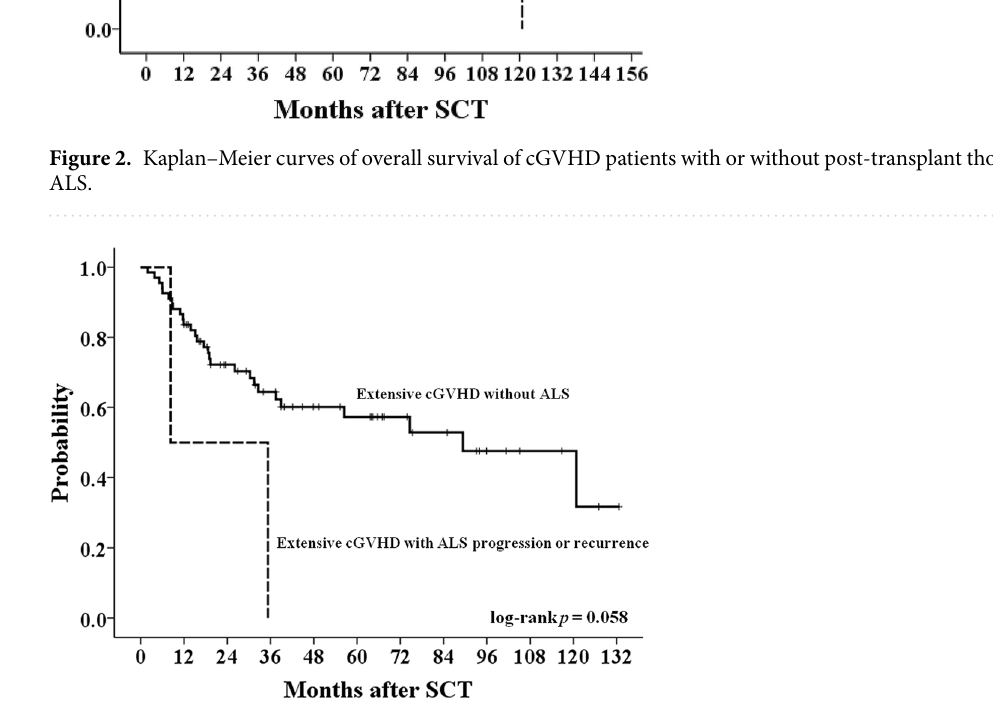
Figure 3. Kaplan–Meier curves of overall survival for extensive cGVHD patients without thoracic ALS or with thoracic ALS progression or